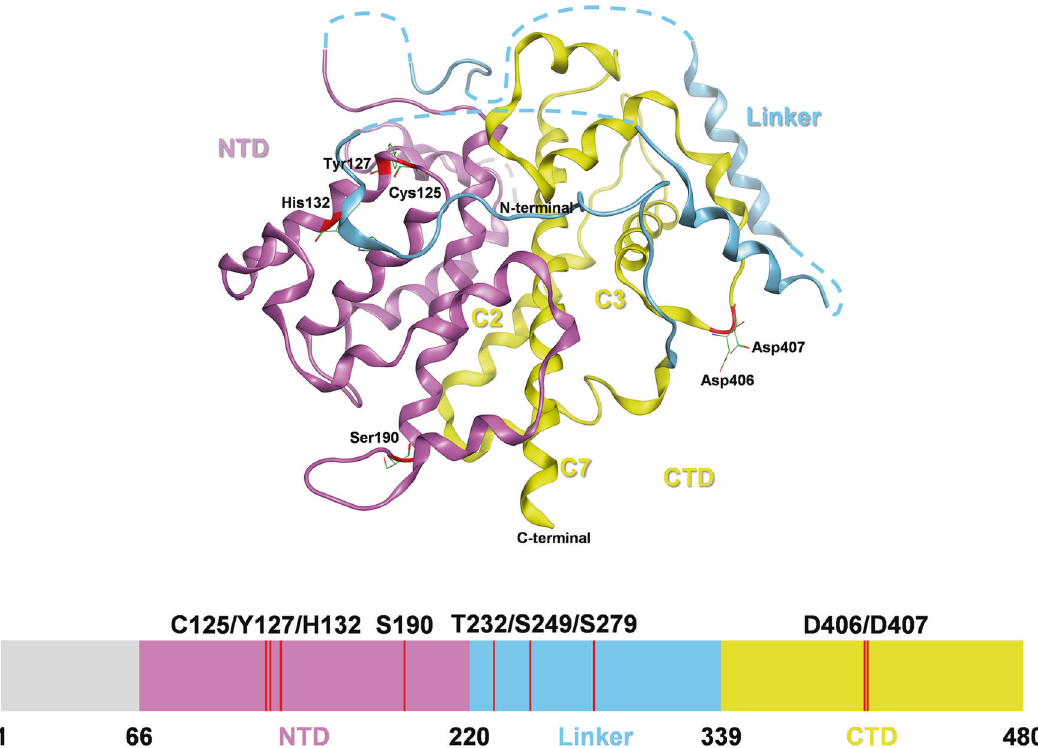
Fig. 1 The crystal structure and functional domains of human SESN2. SESN2 is shown as a ribbon diagram with NTD, Linker, and CTD labeled as pink, blue, and yellow, respectively. The disordered regions (1 – 65, 222 – 232, 241 – 255, 272 – 280, 296 – 309) are labeled as dash lines. The locations of key residues (C125, Y127, H132, S190, T232, S249, S279, D406, and D407) are marked in